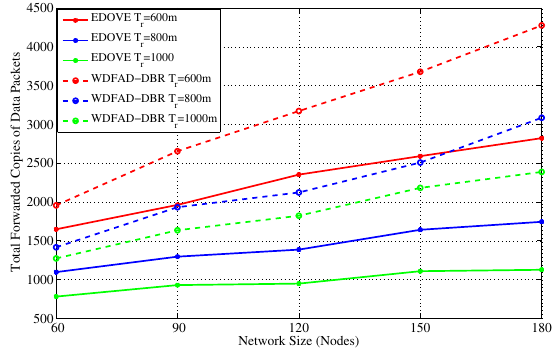
Figure 5. Number of forwarded copies of data messages in the network for different network